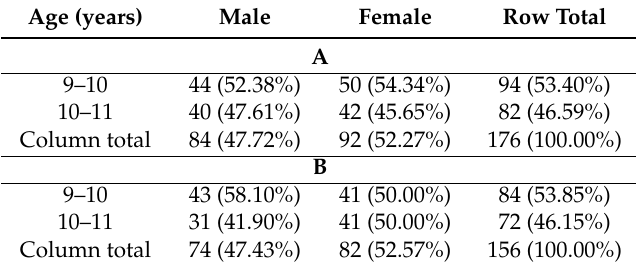
Table 1. Composition of the study group: all children at baseline (panel A), children who completed follow-up (panel